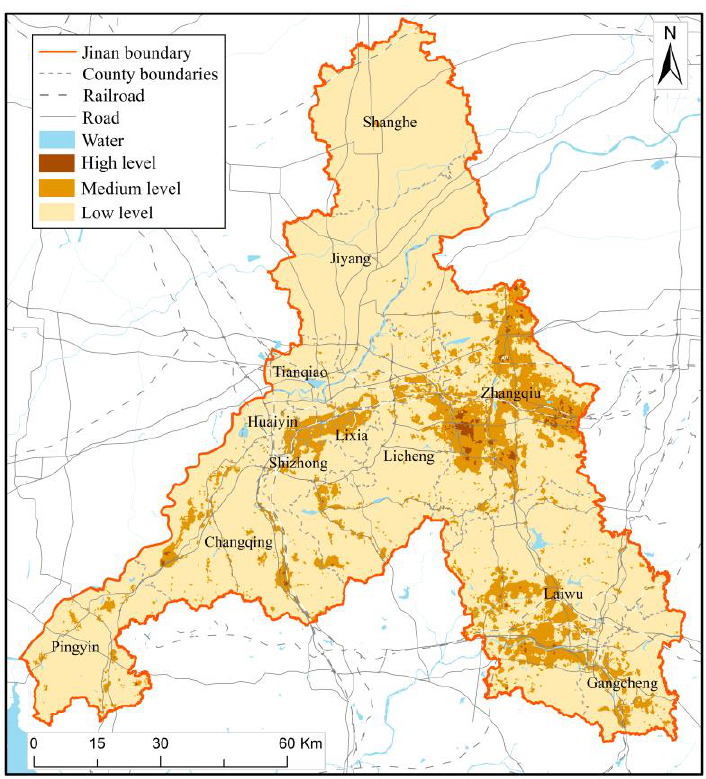
Figure 7. Result map of multi-disaster integrated risk assessment.